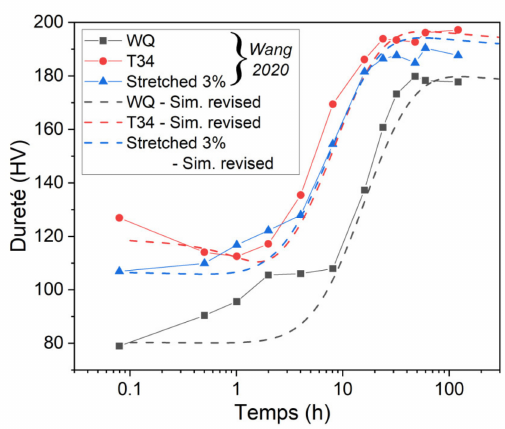
Figure 12. The experimental and simulated hardness evolution in WQ, T34, and Stretched 3% samples during artificial aging at 155 ◦ C. The revised model is used for the simulations. Experimental data comes from Wang et al. [11].